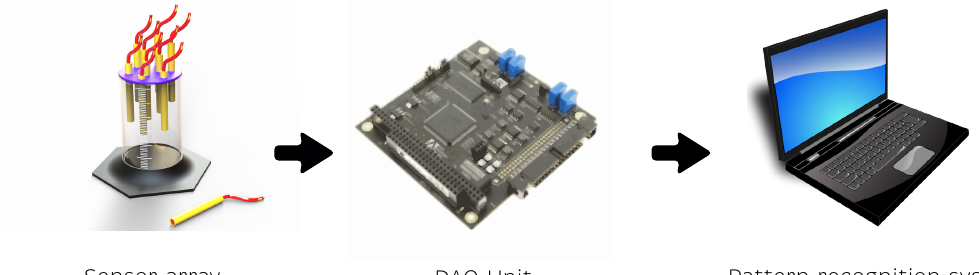
Figure 1. Electronic tongue